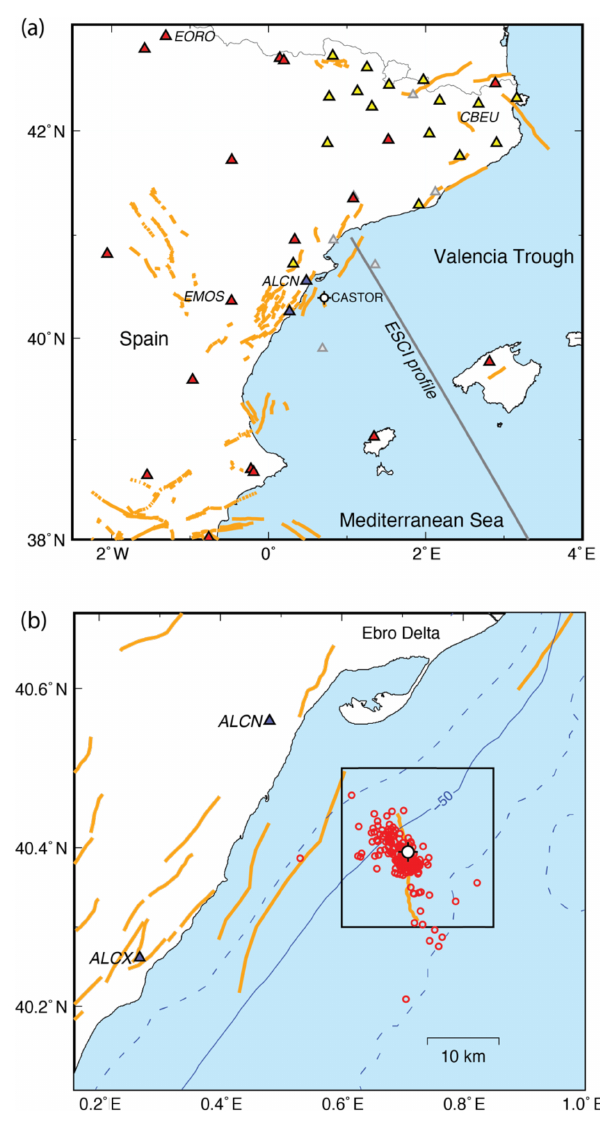
Figure 1. (a) Location of the CASTOR UGS (white circle) and permanent seismic stations in the study region. Blue triangles: Ebro Observatory (network code EB); red triangles: IGN (ES); yel- low triangles: ICGC (CA); grey triangles: permanent stations not used (not available, not operating at the time, or with instrumen- tation problems). Station codes of stations cited in the text are la- beled. (b) Zoom-in of the region of the CASTOR UGS showing bathymetry in meters (dashed lines are every 25m), and earthquake locations of the 2013 sequence (red circles), relocated by Gaite et al. (2016). The black box indicates the region shown in Fig.